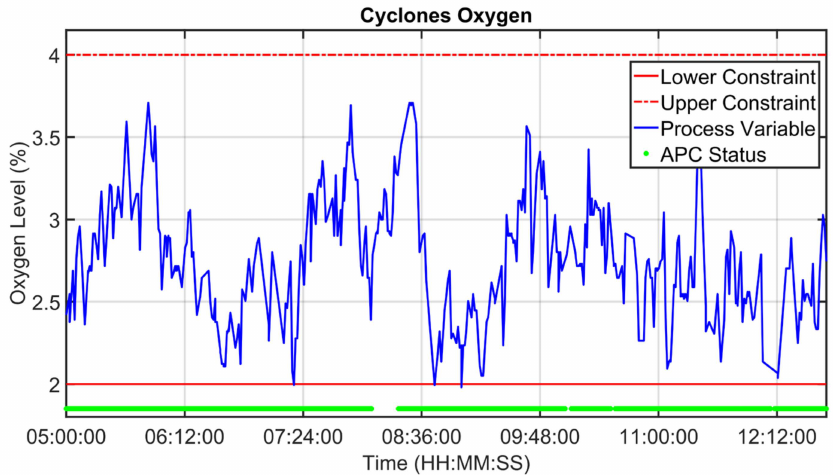
Figure 19. Rotary kiln APC system: field results (cyclone oxygen